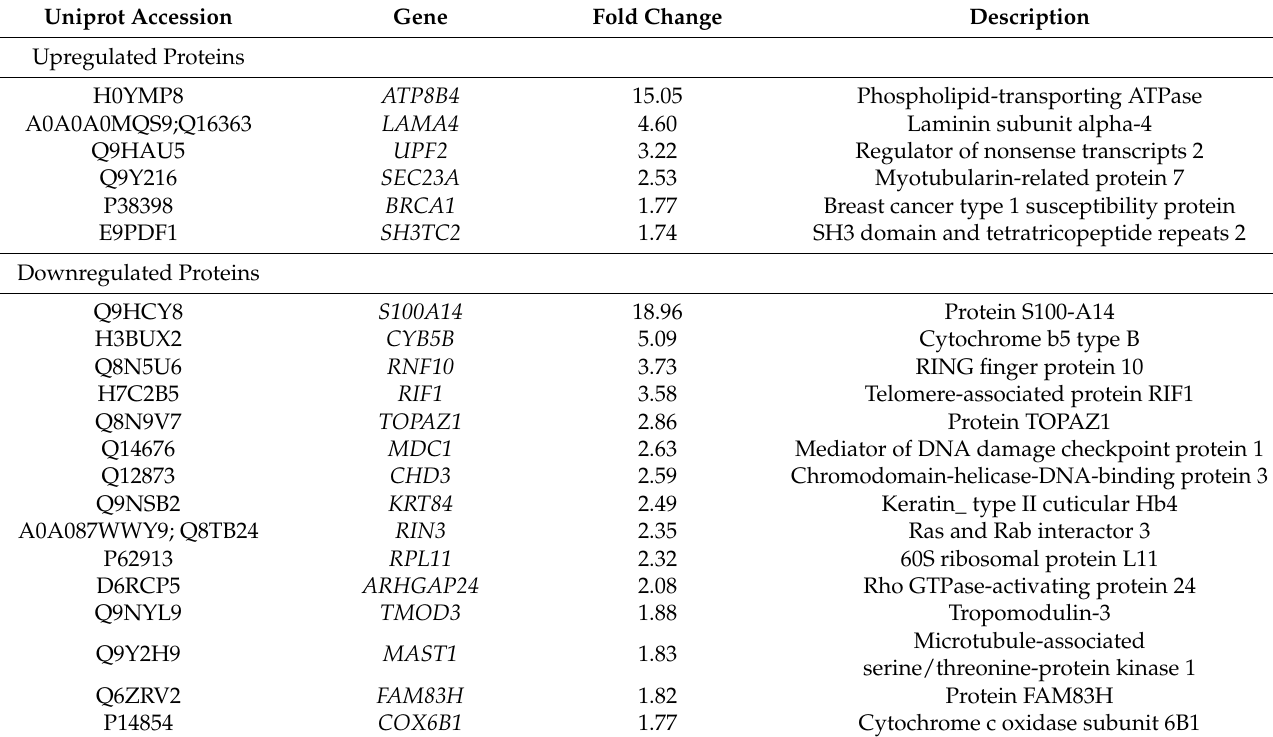
Table 2. Differentially expressed proteins in the MCF7 cells treated with the synergistic AP-1 and DOX combination. Uniprot Accession Gene Fold Change Description